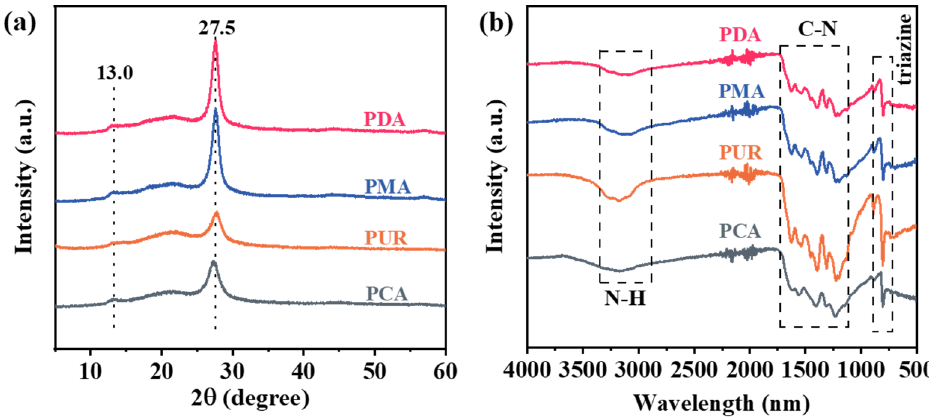
Figure 1. ( a ) XRD spectra, ( b ) FT-IR spectra of PDA, PMA, PUR and PCA samples.